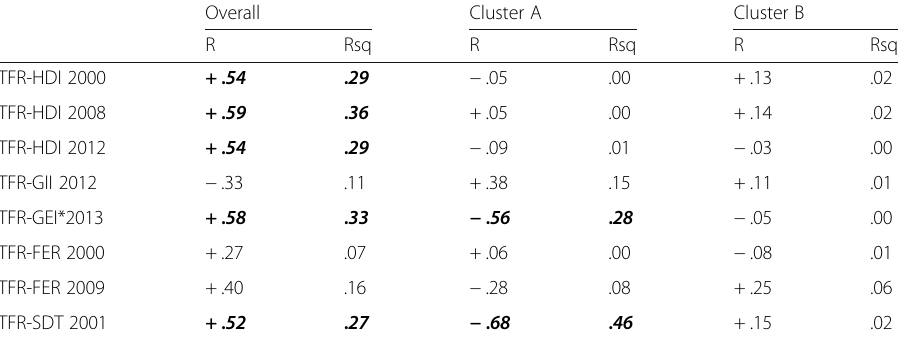
Table 1 Correlation between the national PTFRs and selected social indicators of human development (HDI), gender relations (GII, GEI*), female labour force participation (FER) and second demographic transition pattern (SDT): European countries Overall Cluster A Cluster B R Rsq R Rsq R Rsq TFR-HDI 2000 + . 54 . 29 − .05 .00 + .13 .02 TFR-HDI 2008 + . 59 . 36 + .05 .00 + .14 .02 TFR-HDI 2012 + . 54 . 29 − .09 .01 − .03 .00 TFR-GII 2012 − .33 .11 + .38 .15 + .11 .01 TFR-GEI*2013 + . 58 . 33 − . 56 . 28 − .05 .00 TFR-FER 2000 + .27 .07 + .06 .00 − .08 .01 TFR-FER 2009 + .40 .16 − .28 .08 + .25 .06 TFR-SDT 2001 + . 52 . 27 − . 68 . 46 + .15